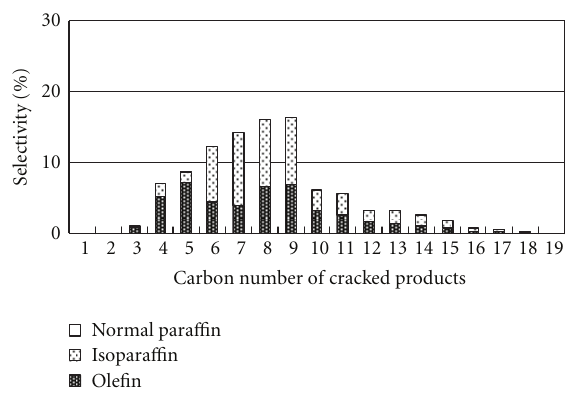
Figure 8: Product distribution from catalytic cracking of hydrot- reated oil over ns Al 2 O 3 /USY catalyst at 350 ◦ C. Table 2: Basic physical properties of ns Al 2 O 3 /GaAlMFI zeolite